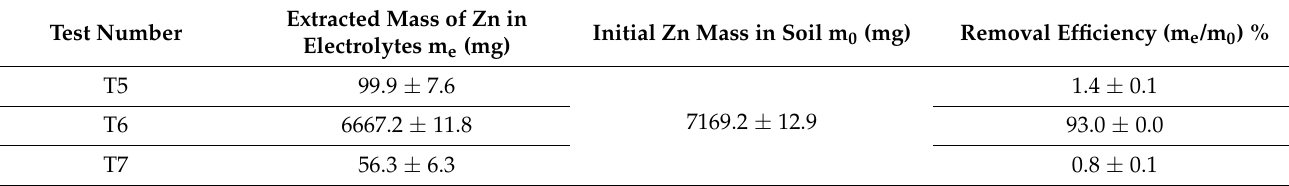
Table 3. Extracted mass of Zn from electrolytes and removal efficiency for T5, T6, and T7.